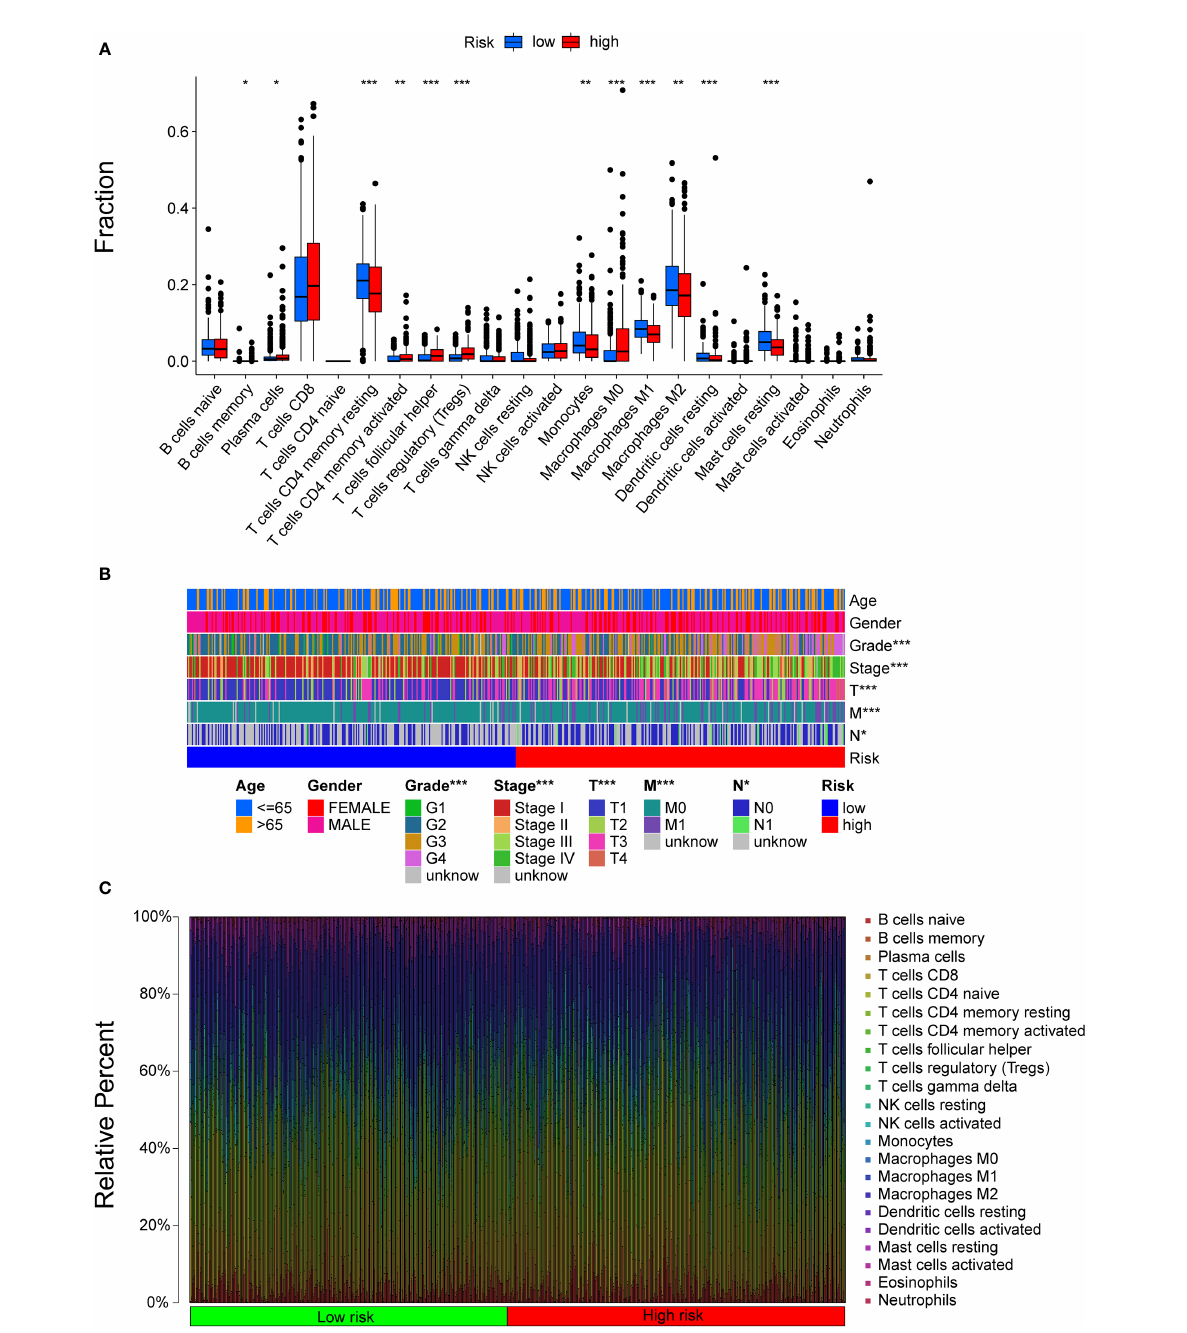
FIGURE 5 The landscape of the TME in ccRCC and the characteristics of different subgroups. (A) The distribution of TME cells in different subgroups. The thick lines are the median value, the bottom and top of the boxes are the 25th and 75th percentiles respectively. Signi fi cant statistical difference between subgroups were explores with the Wilcoxon test (ns, not signi fi cant; * P < 0.05; ** P < 0.01; *** P < 0.001). (B) The clinicopathologic characteristics of different subgroups. (C) The distribution of cells in the TME of 530